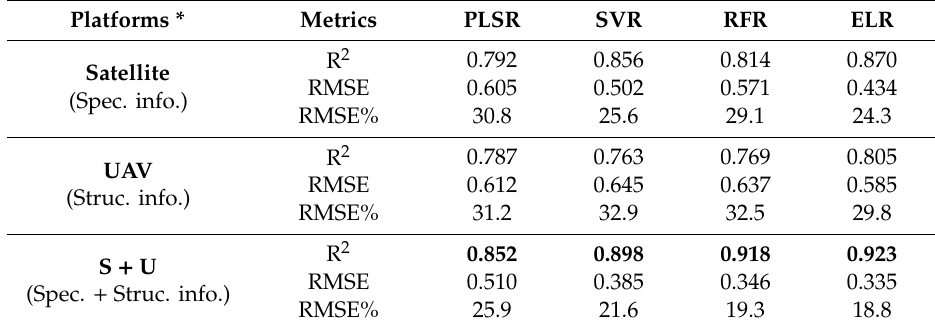
Table 4. Testing results of PLSR, SVR, RFR, and ELR methods for aboveground biomass (AGB) estimation.